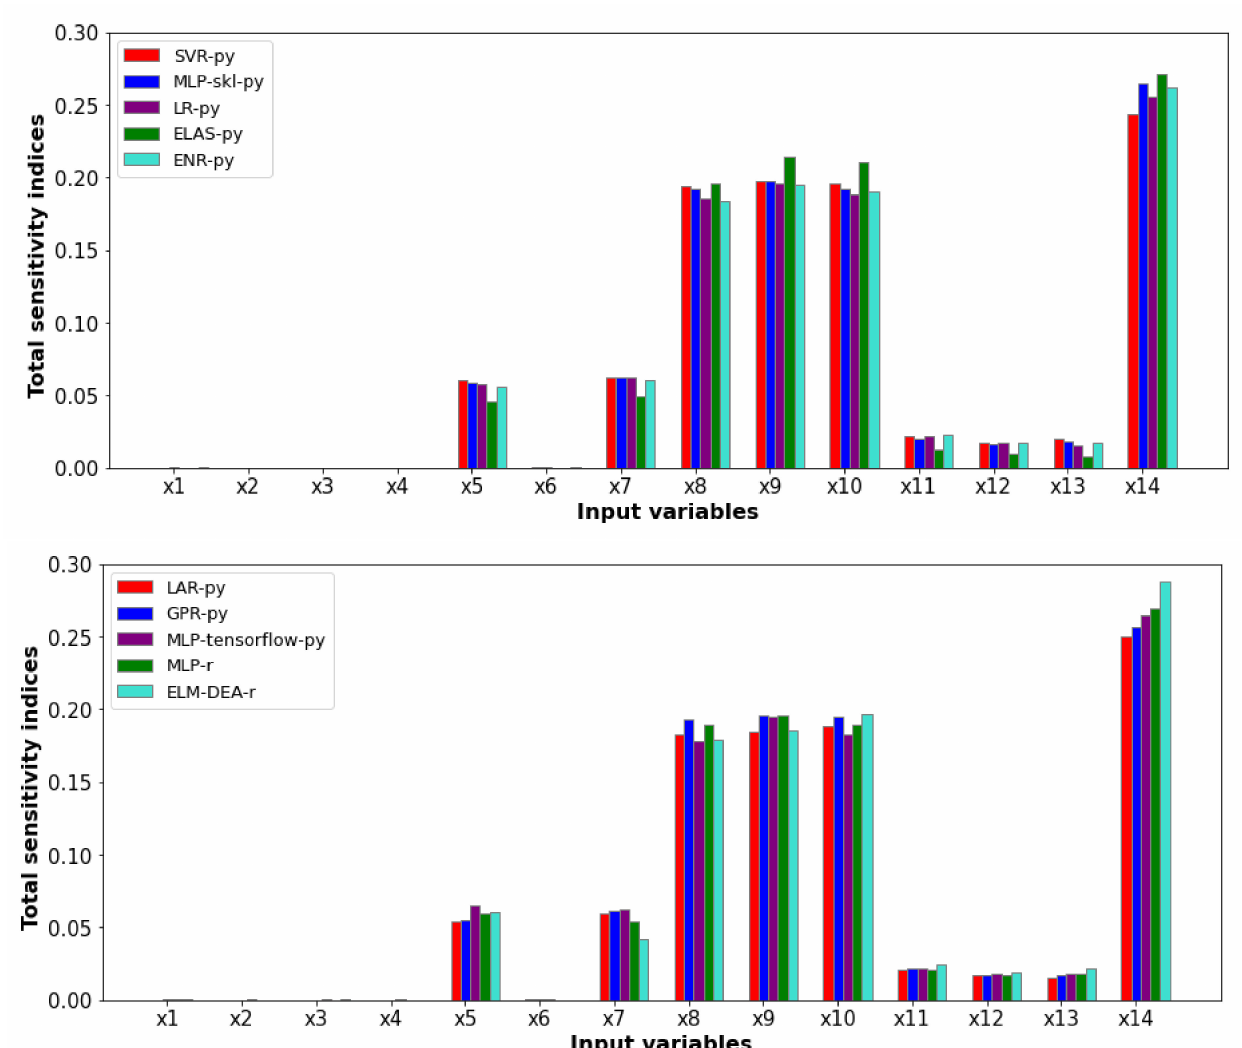
Figure 8. Total sensitivity indices obtained via the Sobol–Jansen method and SMs, copper